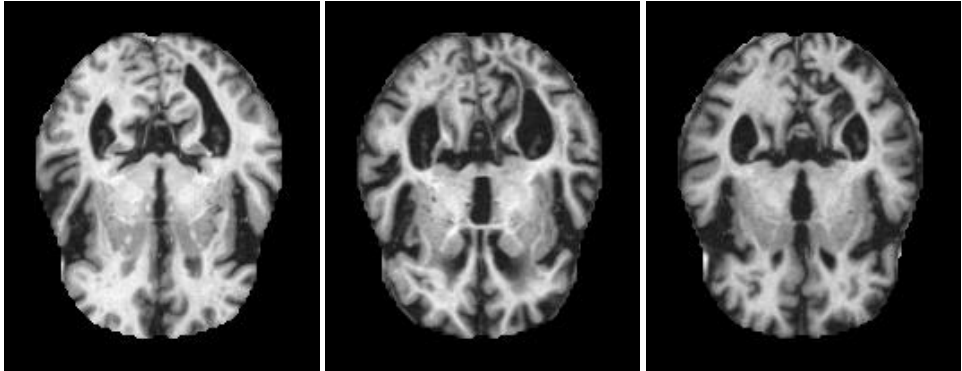
Figure 2. Example of items from the three classes. Left pane : non-demented . Center pane : mild demented . Right pane : moderate demented . MRI images contained in this figure are taken from the original Alzheimer’s data set [53] available on